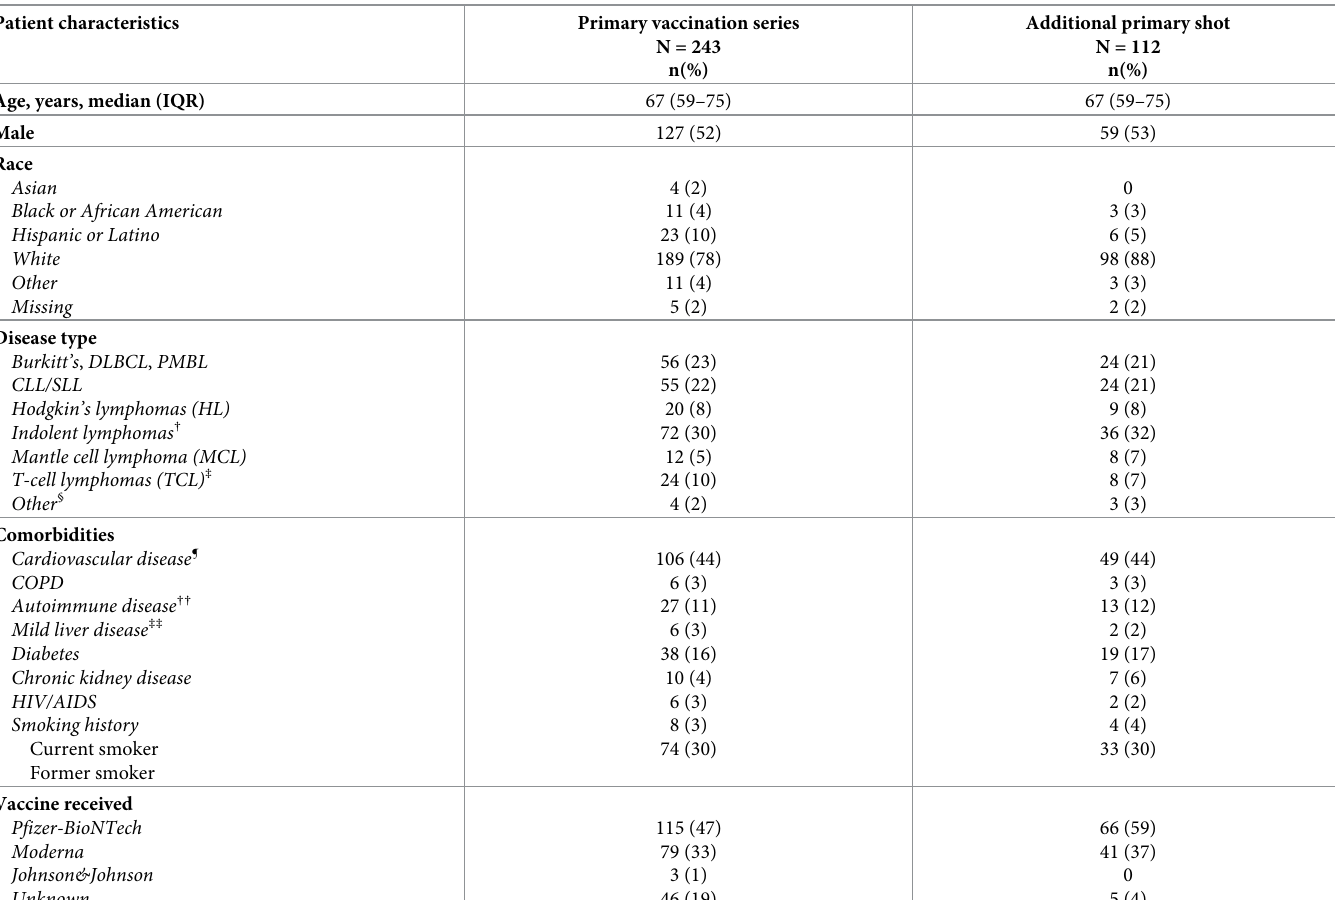
Table 1. Baseline